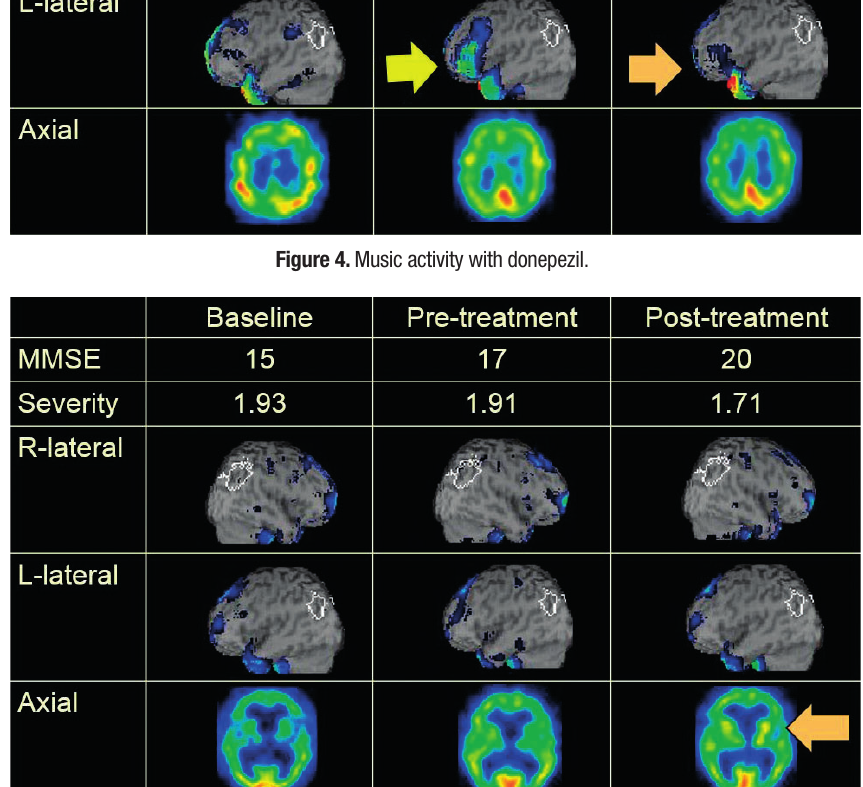
Figure 5. Exercise with donepezil.